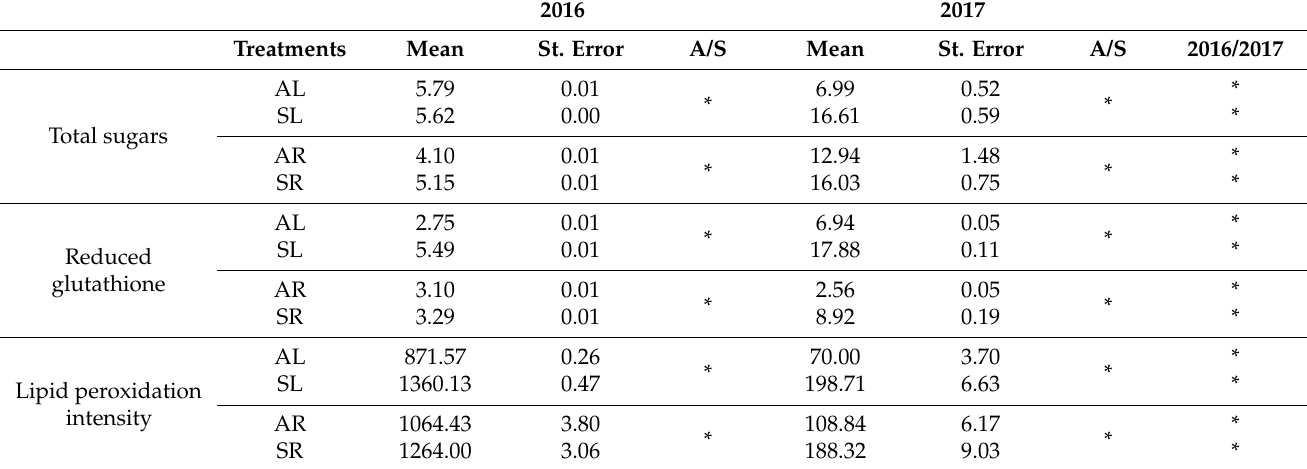
Table 2. Total carbohydrate content (%fresh weight (fw)), reduced glutathione content (GSH, µ mol GSH/g fw), and lipid peroxidation intensity (nmol malondialdehyde (MDA)/g fw) in asymptomatic (A) and symptomatic (S) carrot leaves (L) and roots